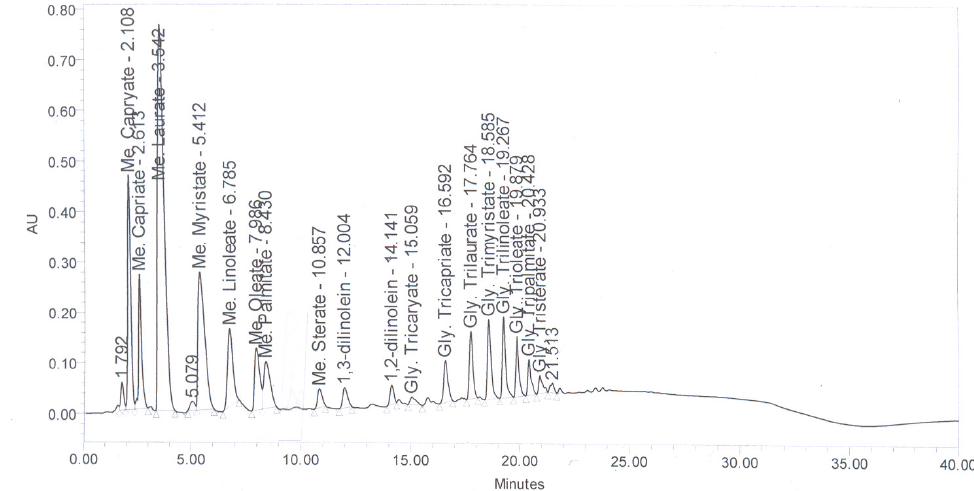
Figure 8. HPLC Chromatogram of coconut oil biodiesel in separating funnel first.